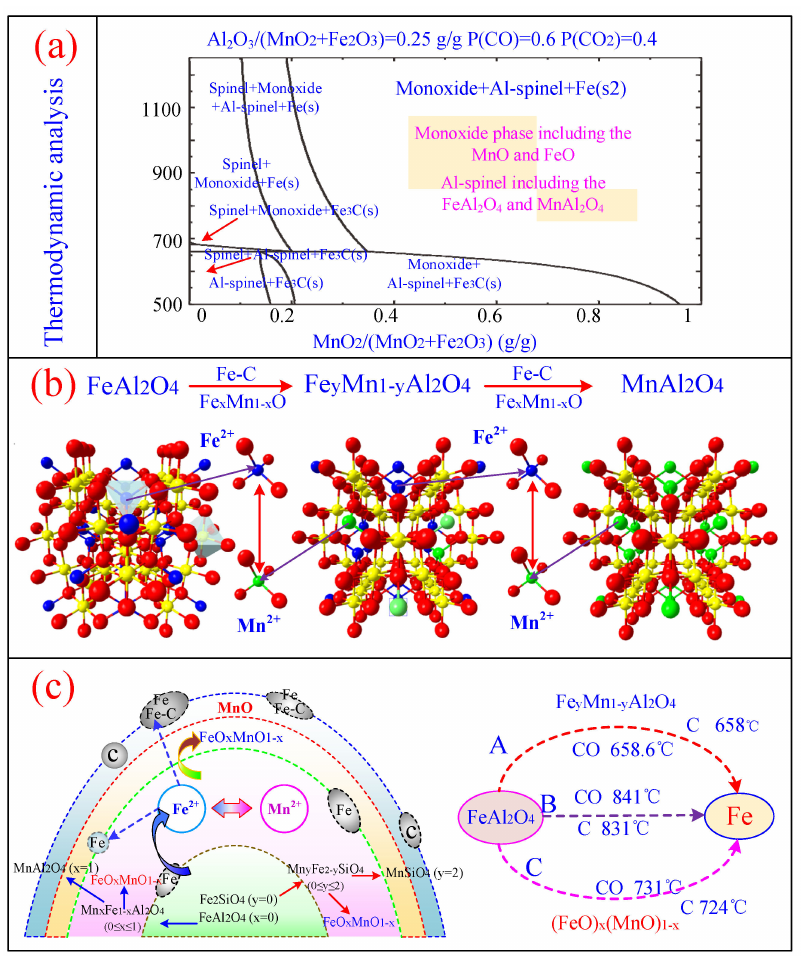
Figure 12. ( a ) Ternary phase diagram of Fe 2 O 3 -MnO 2 -Al 2 O 3 system; ( b ) Crystal structure of the spinel FeAl 2 O 4 and MnAl 2 O 4 ; ( c ) Phase transformation of FeAl 2 O 4 in carbothermic co-reduction